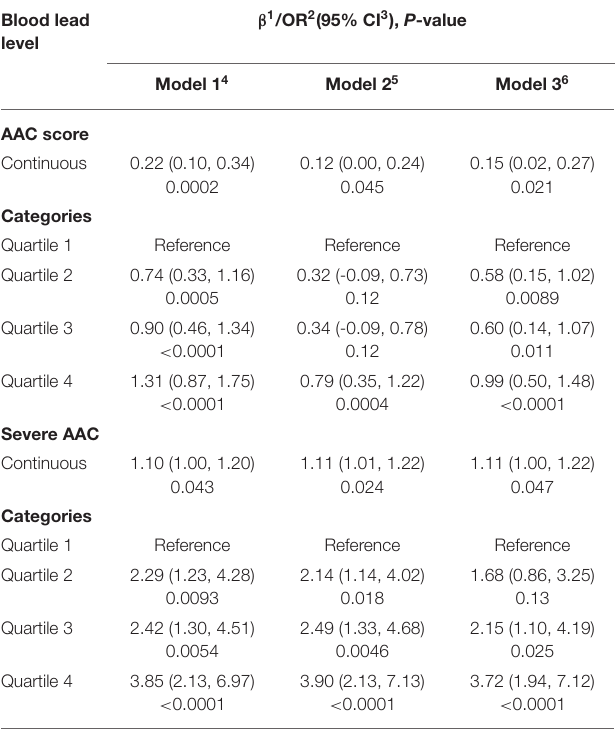
TABLE 2 | Association of blood lead level with AAC score and severe